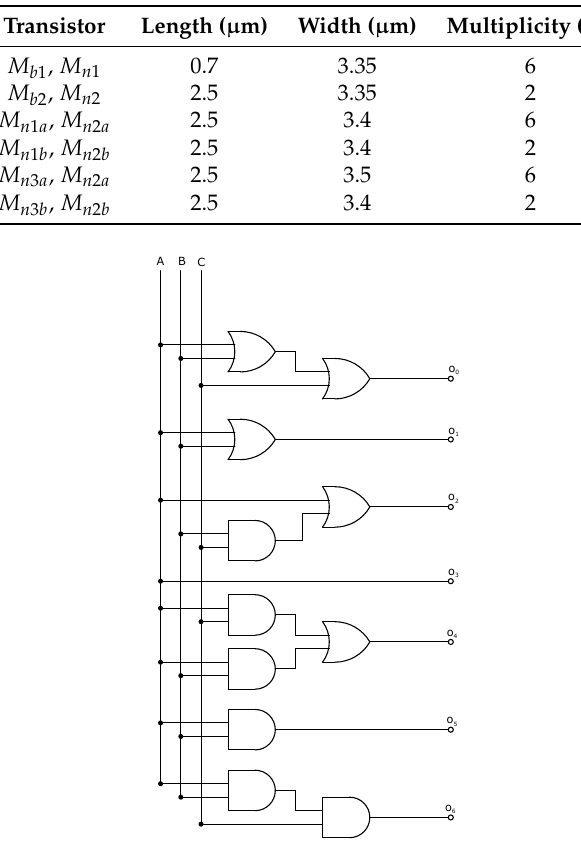
Figure 12. Logic gates to implement the